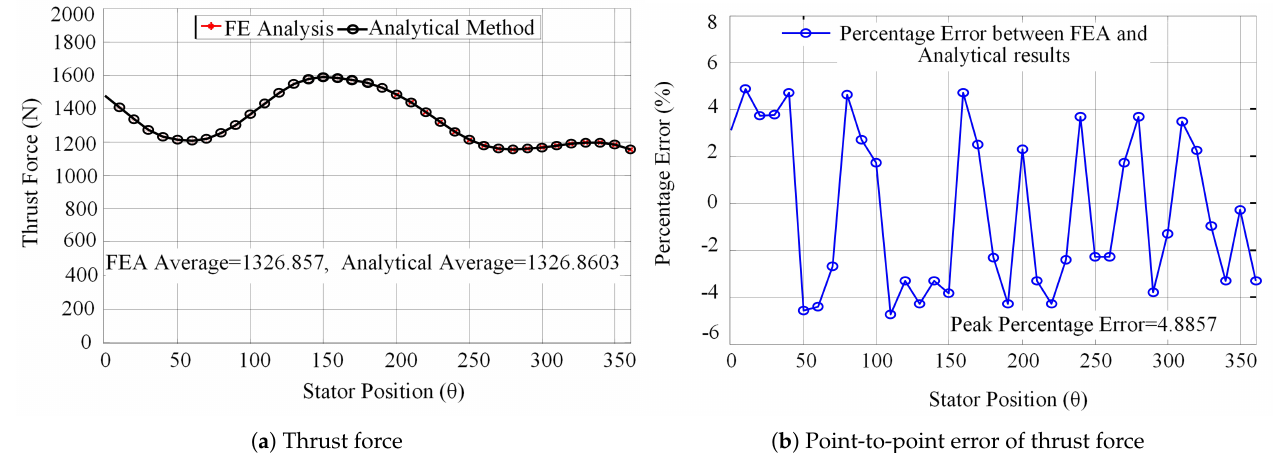
Figure 17. Comparison of thrust force obtained by Maxwell Stress Tensor (MST) and finite element analysis